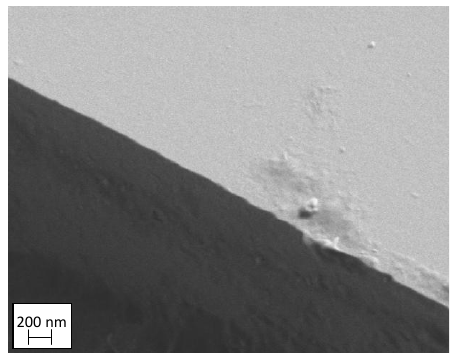
Figure 1. SEM images of the fracture section of as-deposited titania sample deposited onto float glass